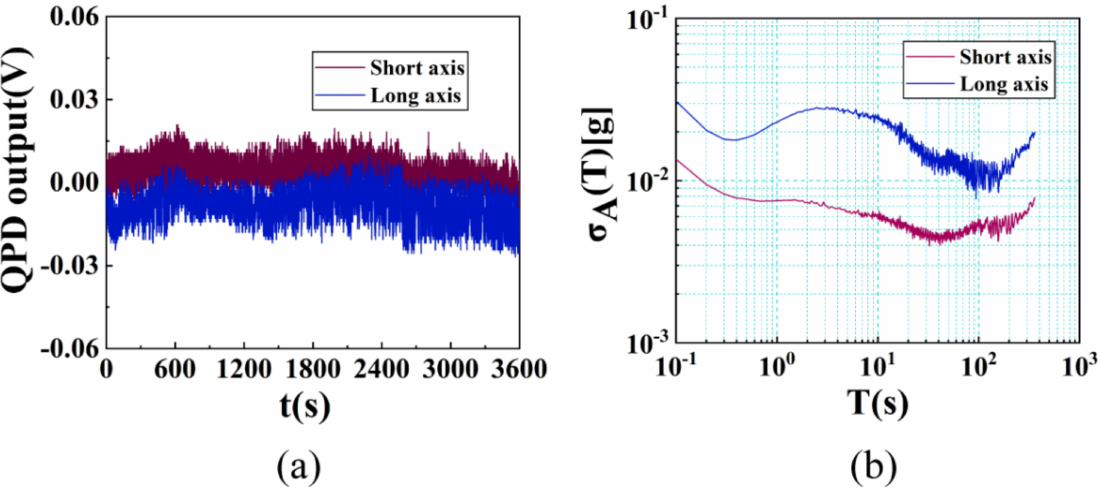
Figure 12. Test of the stability in an hour. ( a ) Original signal of the QPD; ( b ) Allan standard deviation of the accelerometer without external